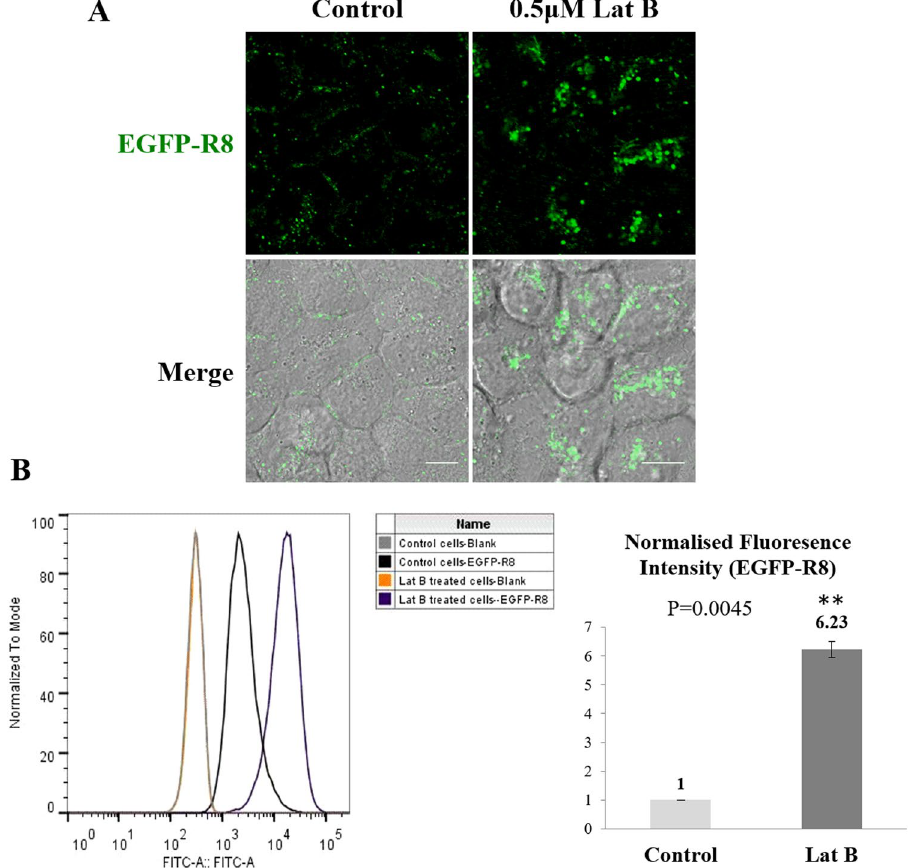
Figure 4. Effects of Lat B on the cellular uptake of EGFP-R8 in A431 cells. Cells were preincubated with either with diluent control or 0.5 μ M Lat B for 30 min prior to incubation with 2 µ M EGFP-R8 for 1 hr in the absence (control) or presence of 0.5 µ M Lat B and washed in heparin. ( A ) Cell associated fluorescence was analysed using confocal microscopy and shown are single projection images of fluorescence only (top rows) and merges of fluorescence and DIC of the same cells. Scale bars 10 µ m. ( B ) Cells treated as in A were washed, trypsinised and analysed by flow cytometry. Data represent the mean of geometric means ± S.D. from three independent